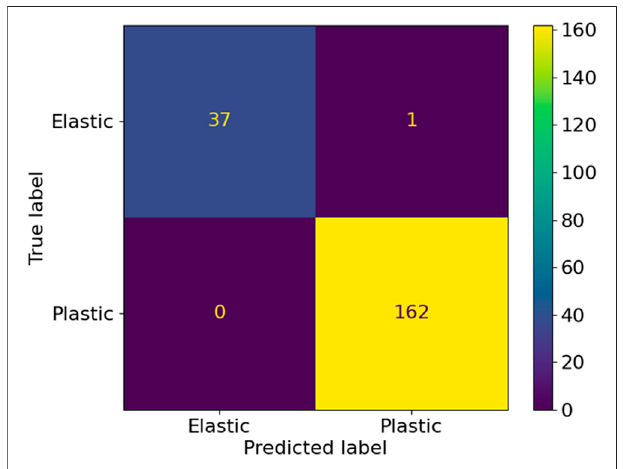
FIGURE 17 | Confusion matrix comparing the trained ML yield function and the reference Barlat-type yield function for 200 random stress tensors in the vicinity of the yield